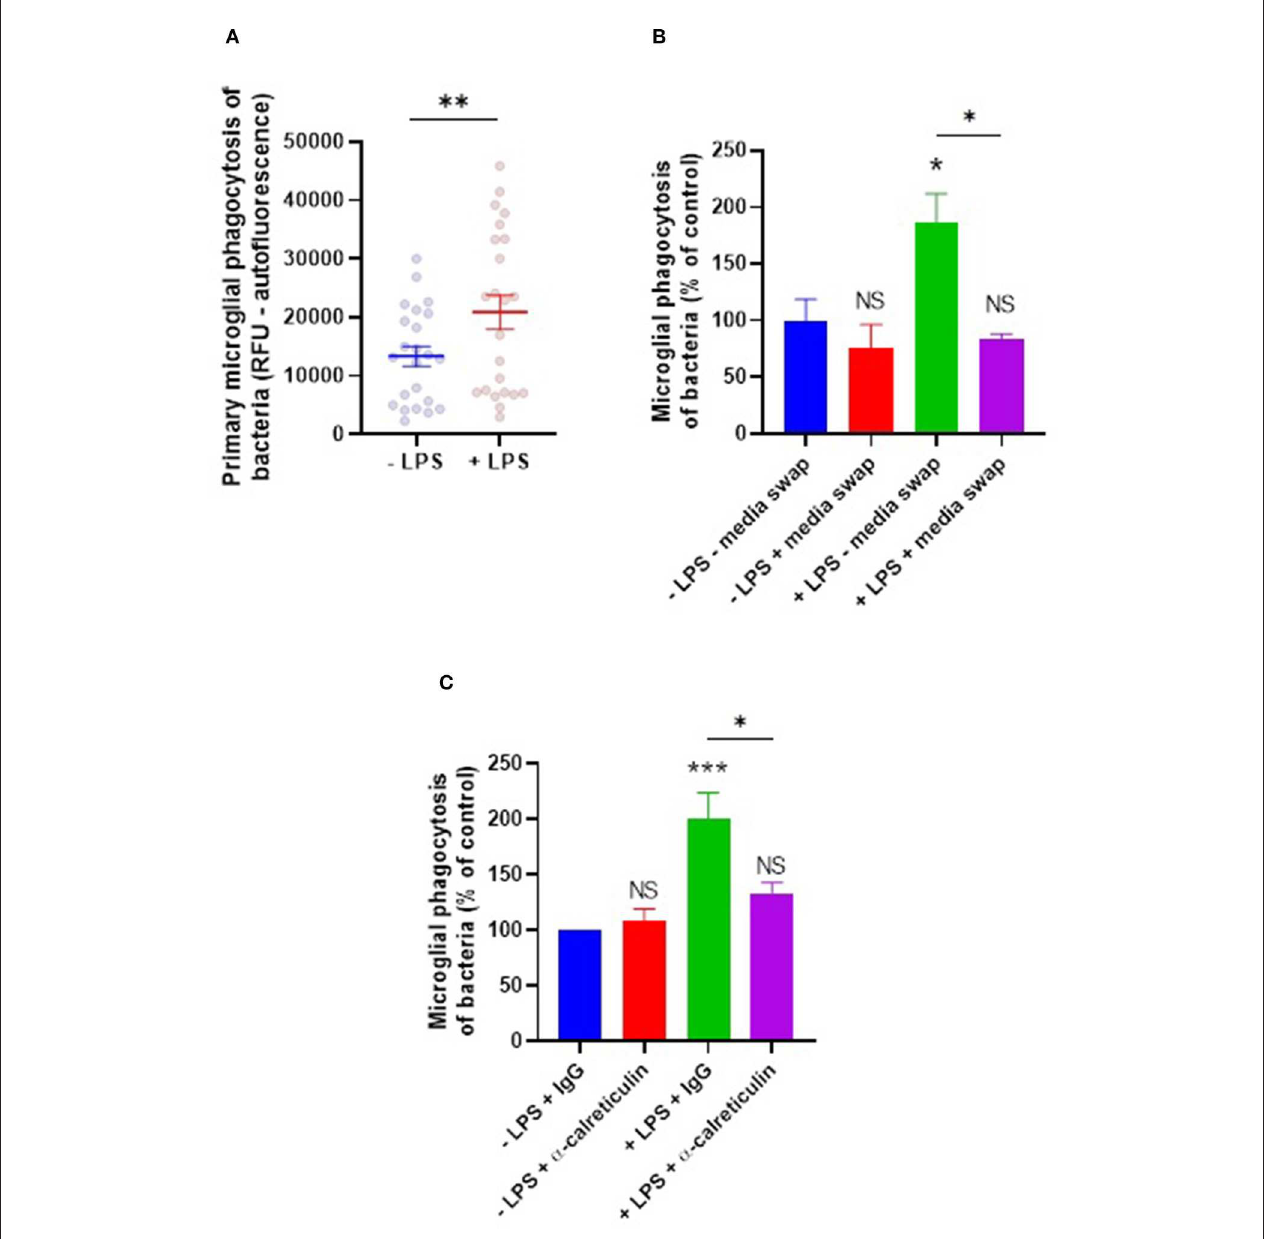
FIGURE 5 | LPS-induced phagocytosis of bacteria by primary microglia is mediated by extracellular calreticulin. (A) Primary rat microglia stimulated by LPS (100ng/ml) for 24h significantly increase their phagocytosis of E. coli compared to the “-LPS” control. (B) LPS-induced phagocytosis is inhibited by applying a media swap immediately prior to bacterial addition, compared to the “–LPS – media swap” control. (C) LPS-induced phagocytosis is inhibited in the presence of a function-blocking anti-calreticulin antibody, compared to the “–LPS + IgG” control. Values are means ± SEM of at least three independent experiments. Statistical comparisons were made via student’s t -test (A) or via two-way ANOVA (B,C) . NS p ≥ 0.05, * p < 0.05, ** p < 0.01, *** p < 0.001 vs. controls, except where indicated by bars over relevant columns.